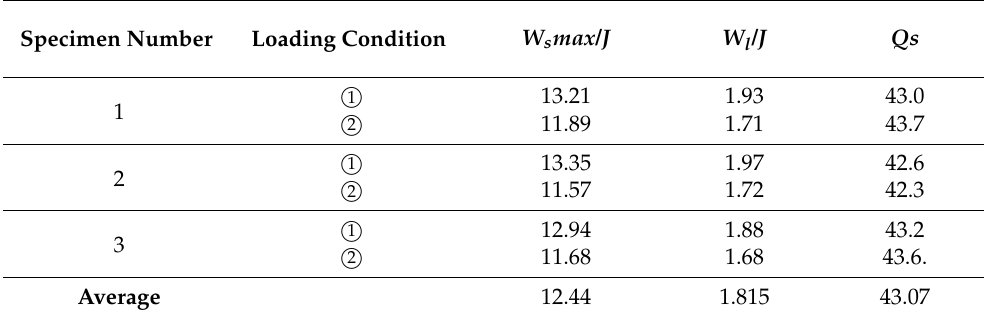
Table 1. Maximum stored energy. W s max , dissipation energy W l and seismic wave quality factor Q s under different loading